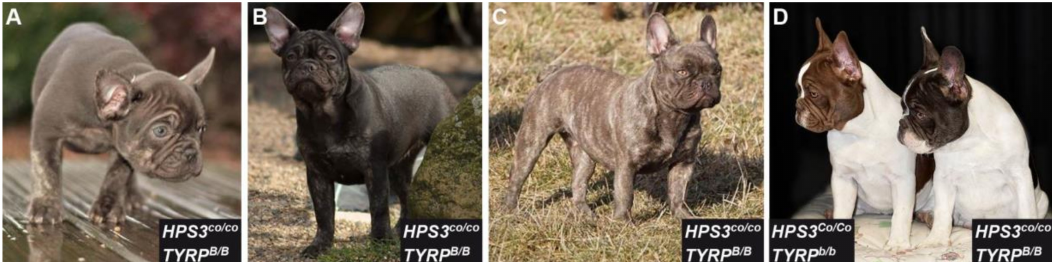
Figure 1. Coat color phenotype of cocoa and chocolate French Bulldogs. Genotypes at the underlying loci are indicated (see Section 3.2) ( A ) Cocoa puppy with brown coat and blue eyes. ( B ) Same dog as shown in ( A ) as an adult. Note that the coat and eye color has markedly darkened over time. ( C ) Cocoa brindled dog. ( D ) TYRP b / b (chocolate) and HPS3 co / co (cocoa) mutant dogs in comparison. In adult dogs, cocoa is slightly darker than TYRP1 -related brown. Photo credits: Heike Ulrich, Joyce